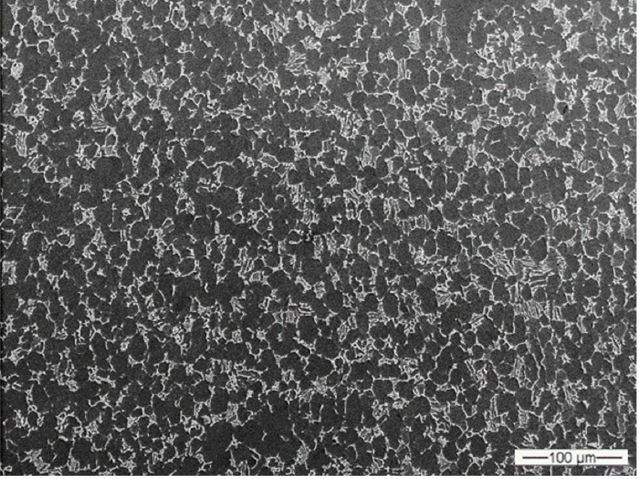
Figure 3. As-received bimodal microstructure.